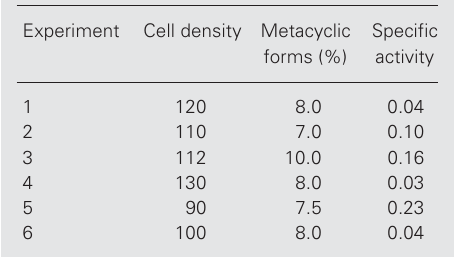
BA Figure 2. (cid:0) Immunocytochemical localization of (cid:1) -L-fucosidase in Trypanosoma cruzi . (cid:0) Ul- trathin sections of (cid:0) epimastigote (A) and trypomastigote (B) forms of T. cruzi were first incubated with anti- (cid:1) -L-fucosidase and then with gold-labeled protein A. Gold particles are seen in the cytoplasm (arrows) and on the surface of the plasma membrane (arrowheads). N: nucleus; K: kinetoplast. Bar: 1 µm. Table 1. Activity of (cid:1) -L-fucosidase in different preparations of Trypanosoma cruzi epimastigote